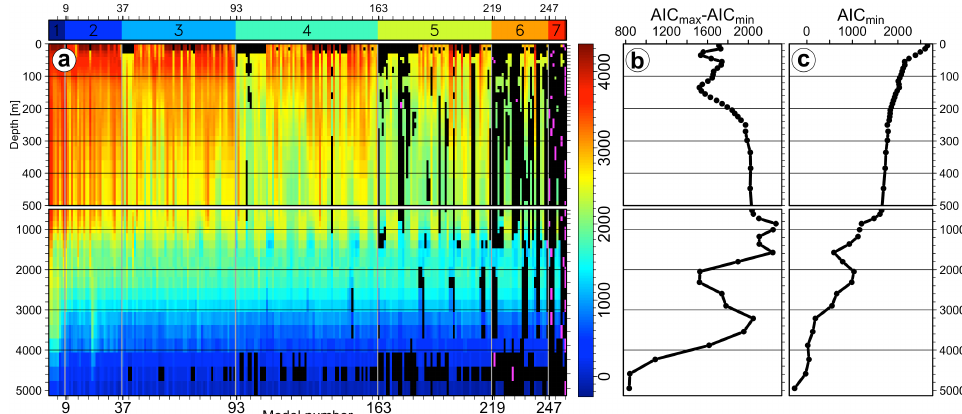
Fig. 5. (a) AIC values as a function of model number (strategy 2) and depth for the July GLODAP 1995 dataset. All models with AIC values within 10% of the depth-specific range in AIC of the minimum AIC value at each depth (highlighted in magenta) are highlighted in black. Tick marks on the right show the vertical location of model layers. Corresponding vertical profiles of (b) the depth-specific range in AIC and (c) the minimum AIC